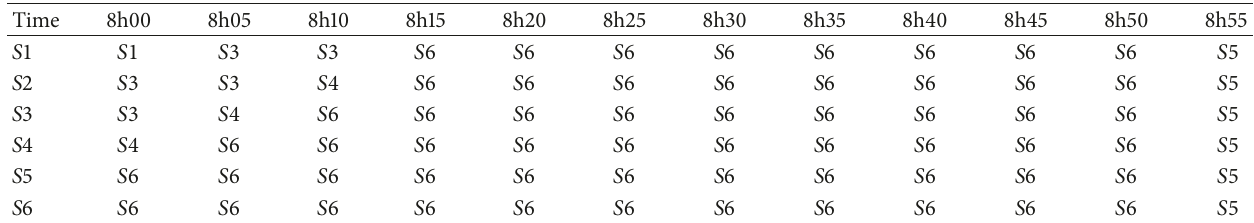
Table 4: Neighborhood prediction. The 1st column indicates the initial states for 𝑃 1 and P